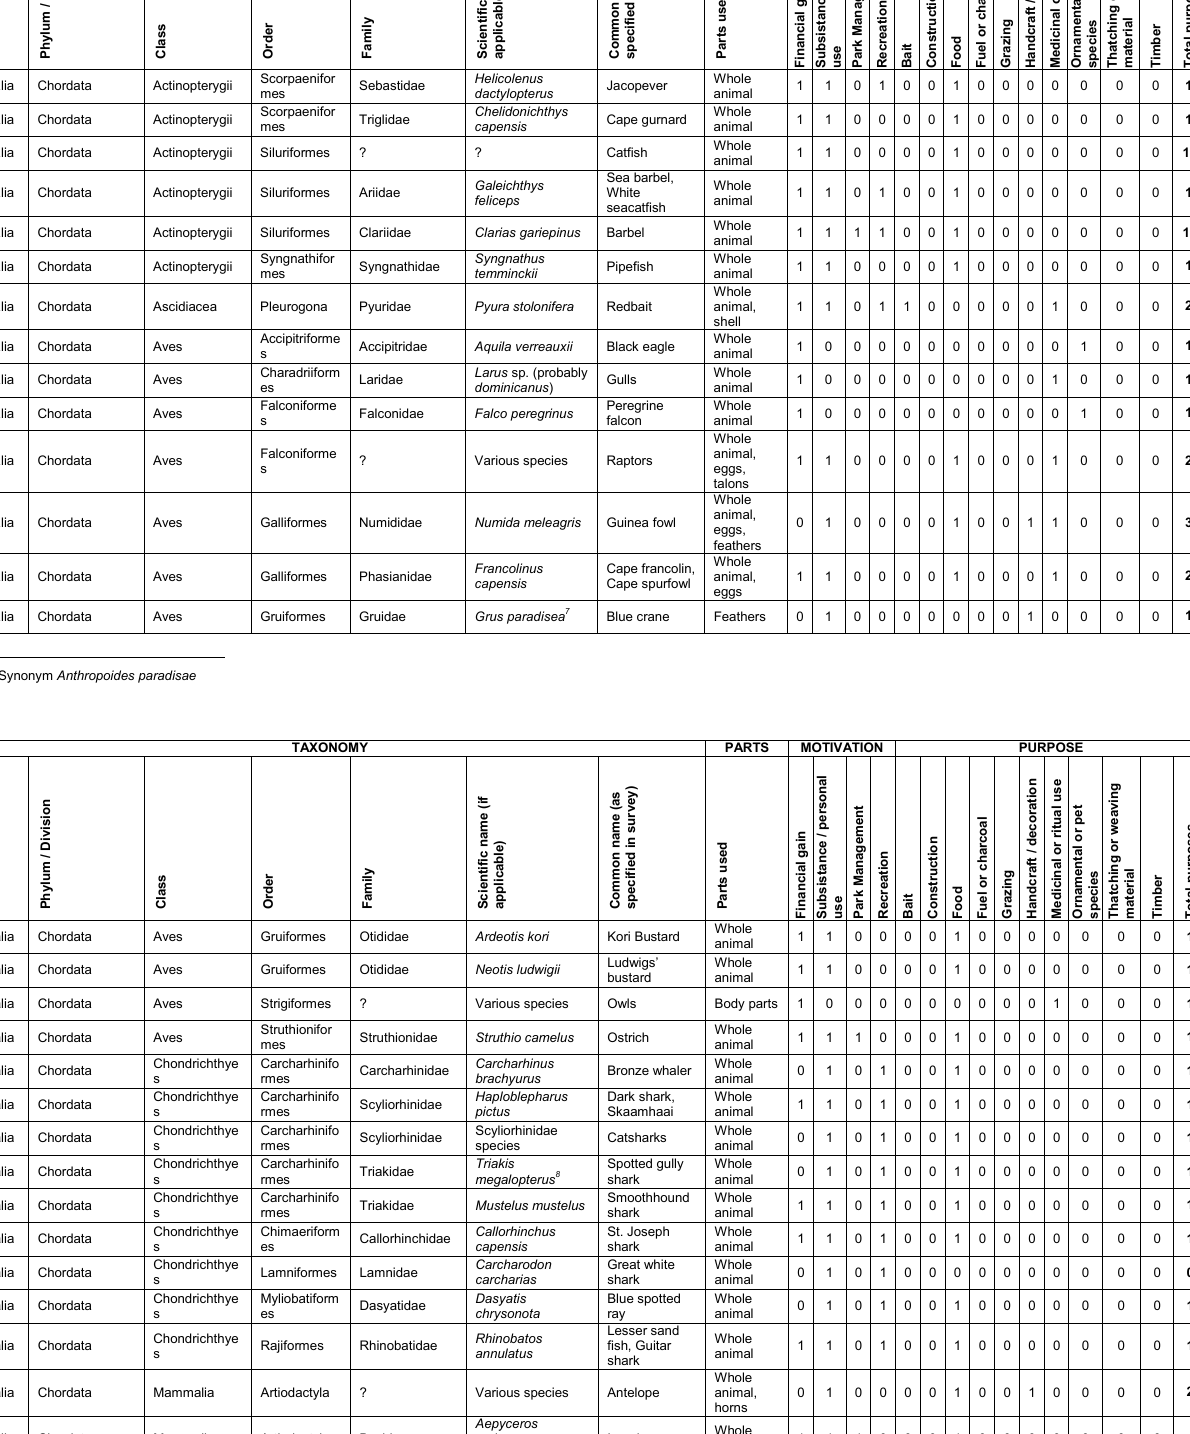
Whole animal, horns Aepyceros Impala Whole melampus melampus